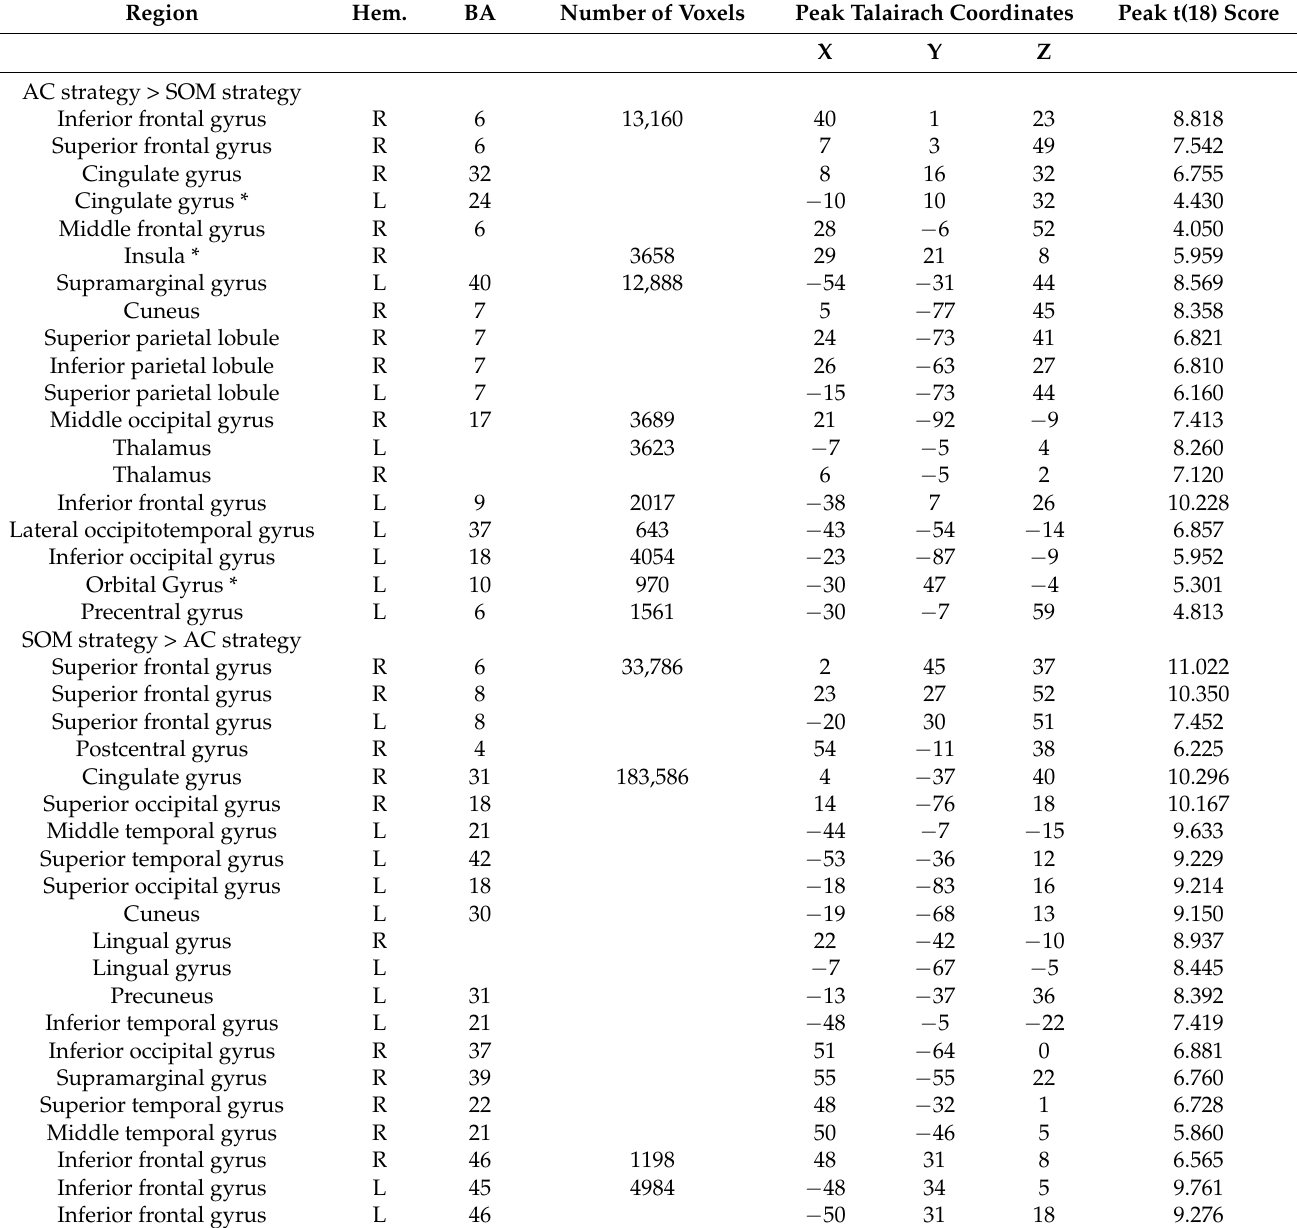
Table 3. Brain areas that showed significant differences between approximate calculations compared to sense of magnitude